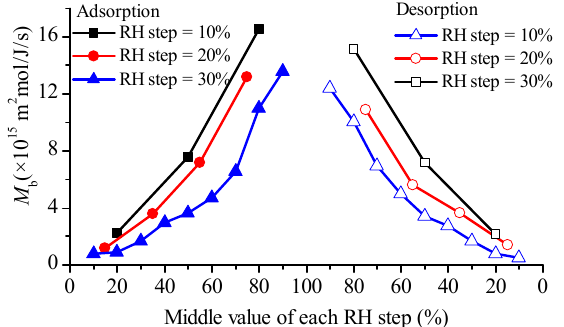
Figure 5. Water mobilities in glutinous rice grains during adsorption and desorption with different RH step sizes obtained according to Fick’s second law when potential chemical gradient was considered as a driving force.